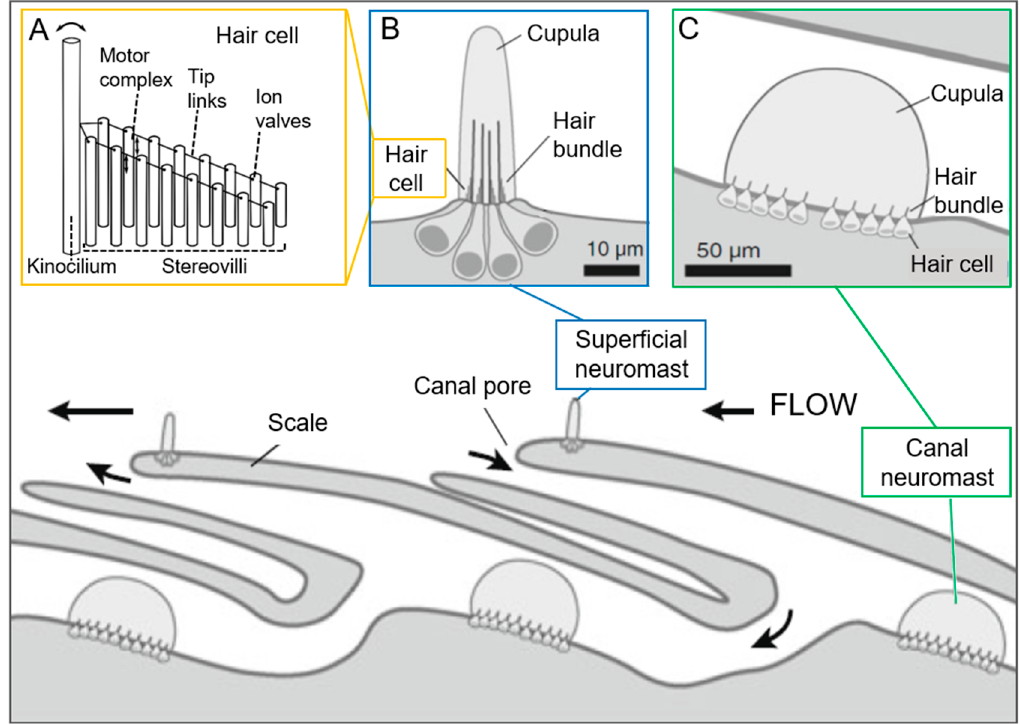
Figure 6 . General structure and position of main components in the lateral line of fish. ( A ) hair cell of ( B ) superficial and ( C ) canal neuromasts (( A ) reprinted from [74] by permission of John Wiley & Sons, Inc.; ( B , C ) and bottom reprinted by permission from Springer, [112]).